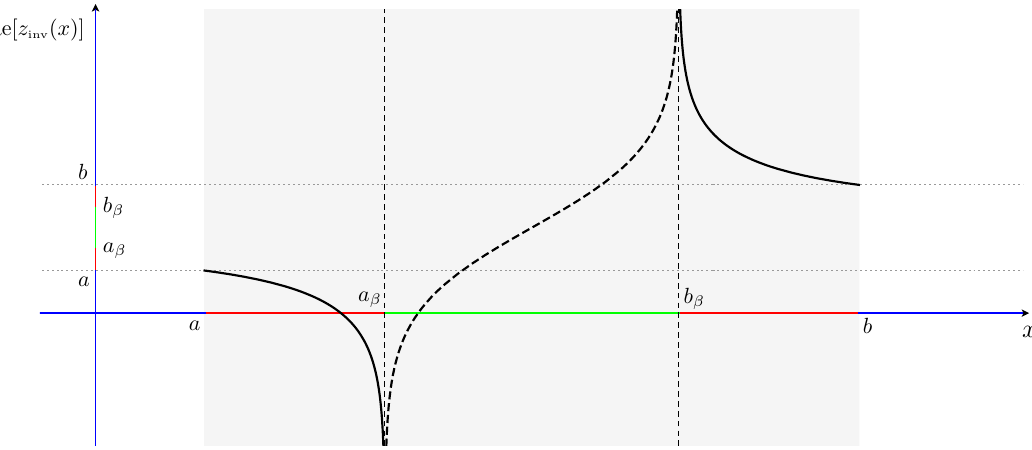
Figure 4 . The real part of the inversion map (5.10). The green segment corresponds to A β , the red segments to A \ A β and the blue half lines to B